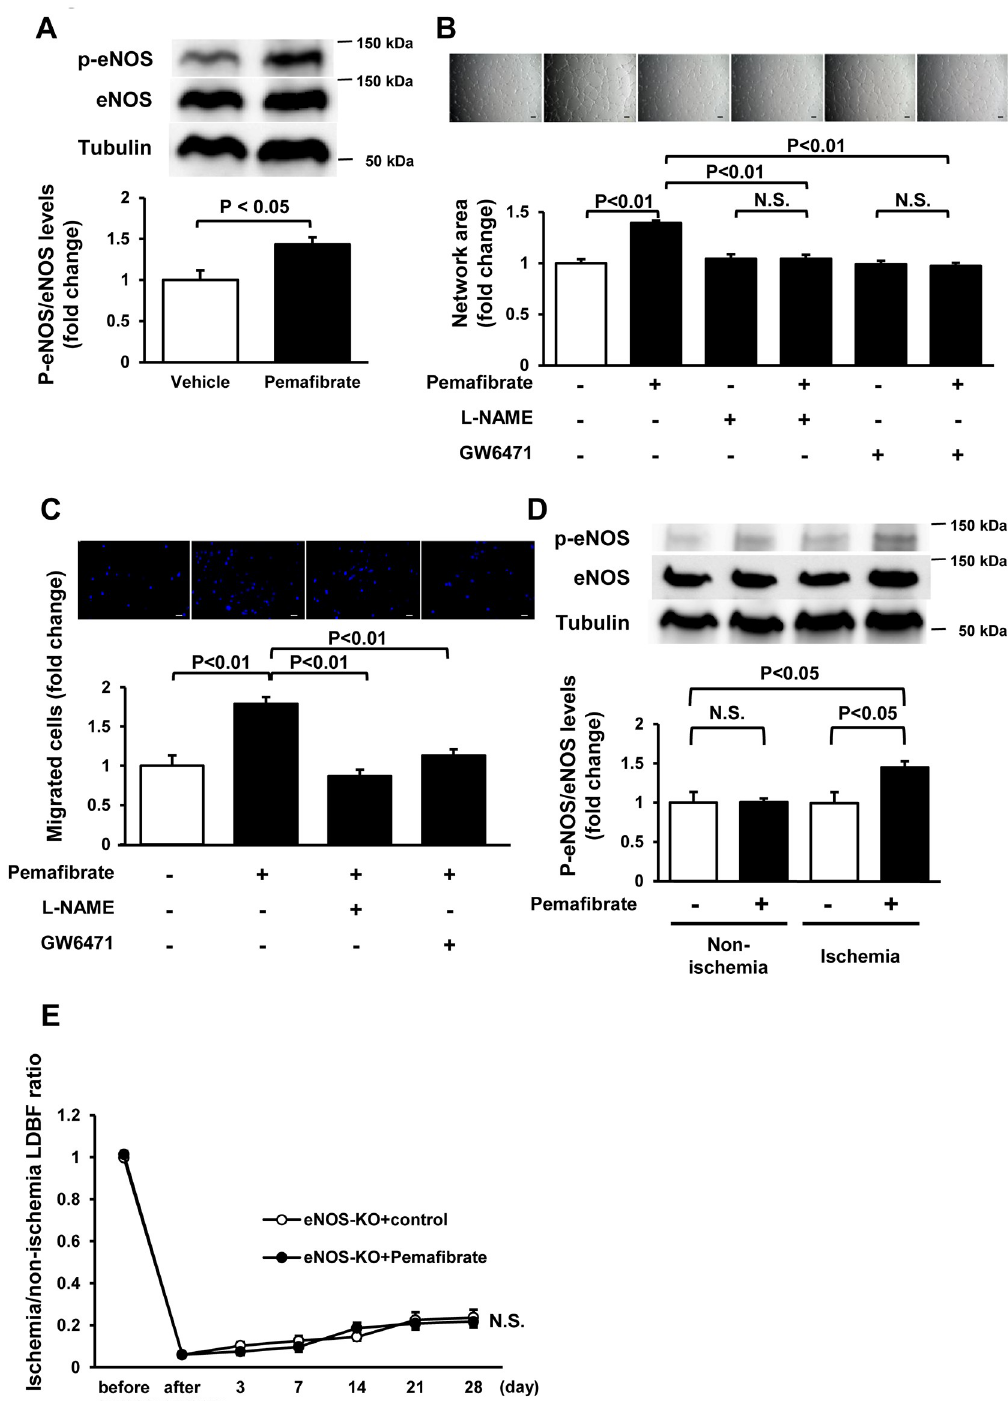
Fig 3. Pemafibrate promotes angiogenic response through the eNOS-dependent pathway. A . Phosphorylation levels of eNOS in HUVECs after treatment with pemafibrate. Upper panels show the representative blots of phosphorylated eNOS (P- eNOS), eNOS and α -tubulin (Tubulin) at 1 h after treatment with pemafibrate (10 nM) or vehicle. Lower panel shows the quantitative analysis of phosphorylation levels of eNOS relative to Tubulin. N = 4 in each group. B and C . Involvement of eNOS and PPAR α in pemafibrate-stimulated enhancement of network formation (B) and migration (C) of HUVECs. HUVECs were pretreated with the NOS inhibitor, L-NAME (500 μ M) or PPAR α specific inhibitor, GW6471 (50 μ M), followed by stimulation with pemafibrate (10 nM) or vehicle. N = 8 in each group (B). N = 4 in each group (C). Scale bars show 200 μ m.